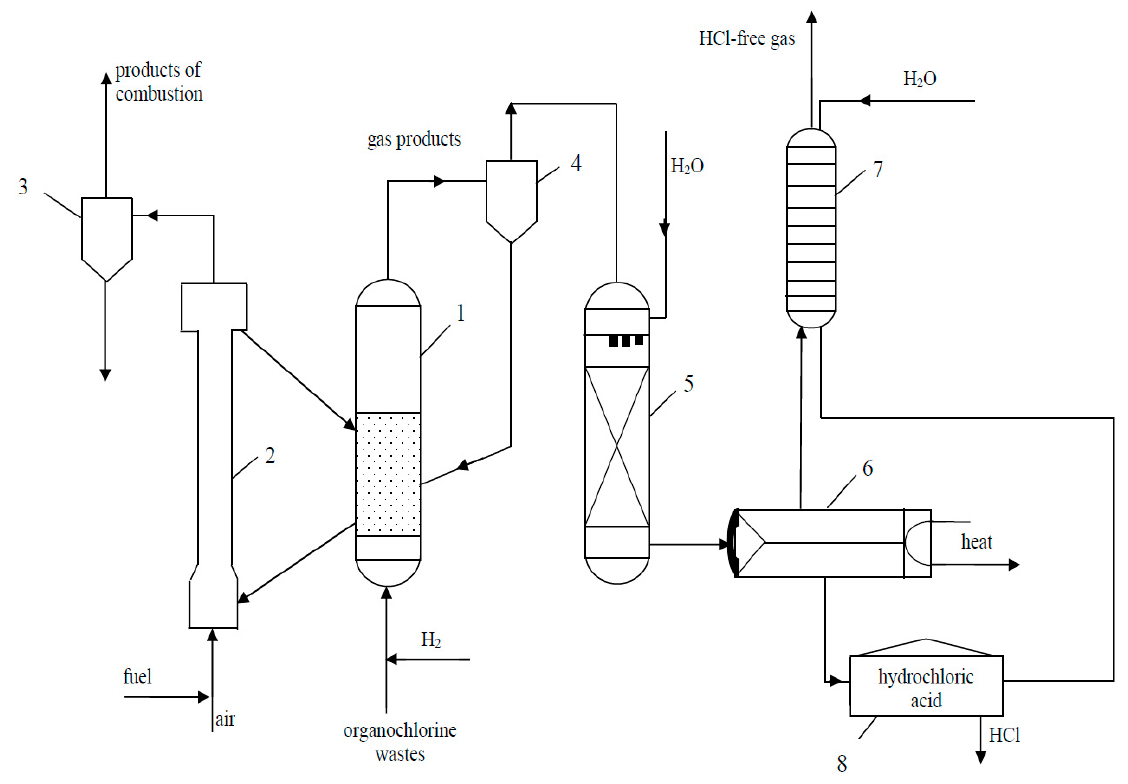
Figure 5. Schematic diagram of thermal hydrodechlorination of organochlorine products.